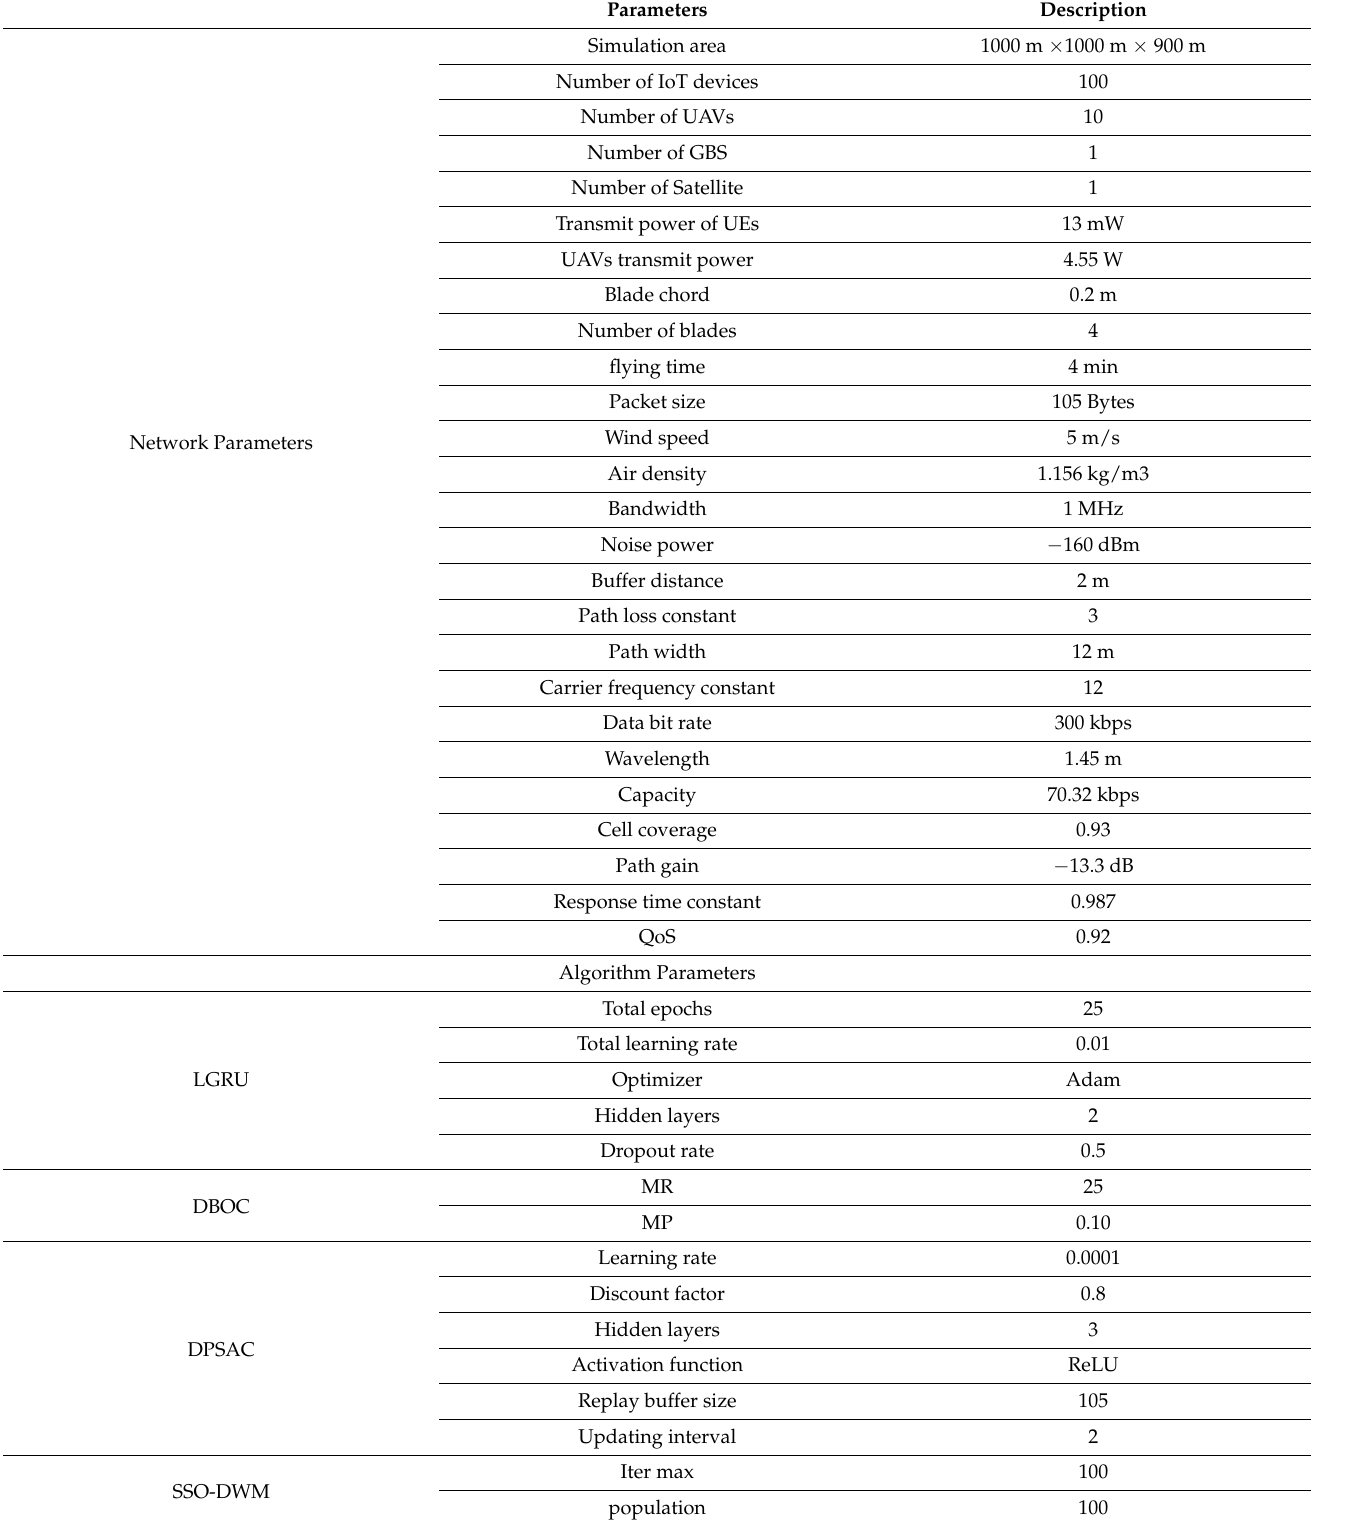
Table 4. Simulation